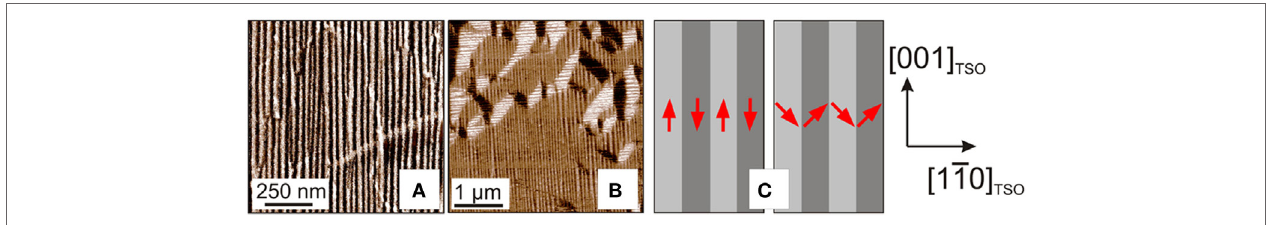
FigUre 4 | Lateral piezoresponse force microscopy image of a 10 nm NaNbO 3 film (a) and a 60 nm NaNbO 3 film (b) on a (110) TbScO 3 (TSO) substrate. (c) Possible in-plane arrangements of polarization vectors in the stripe domains with 180° (left) and 90° (right)